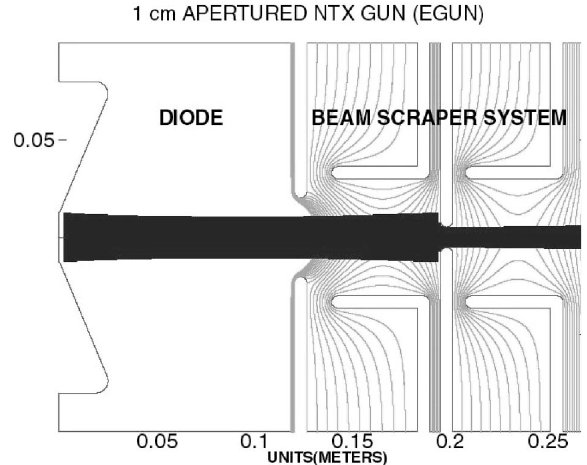
FIG. 11. EGUN simulation of NTX diode and beam aperture.